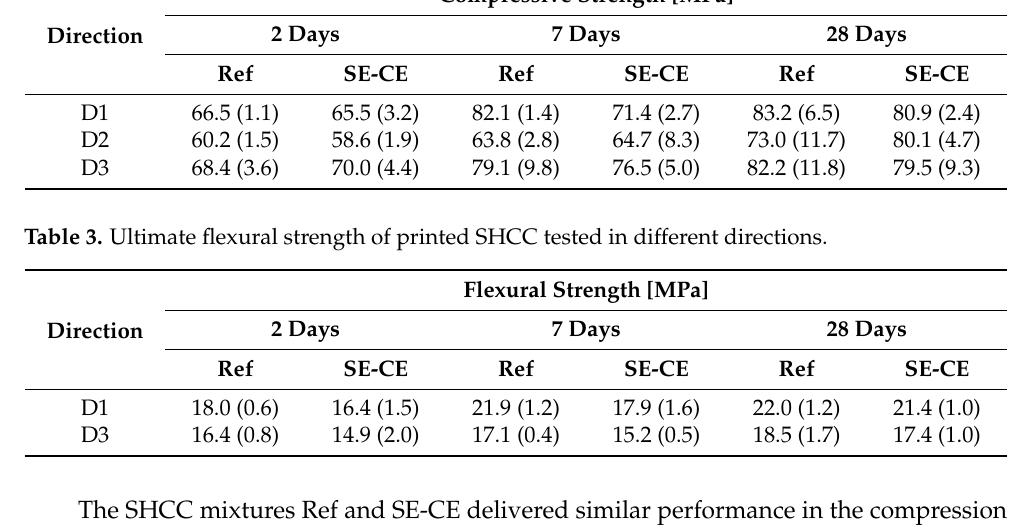
Table 3. Ultimate flexural strength of printed SHCC tested in different directions.